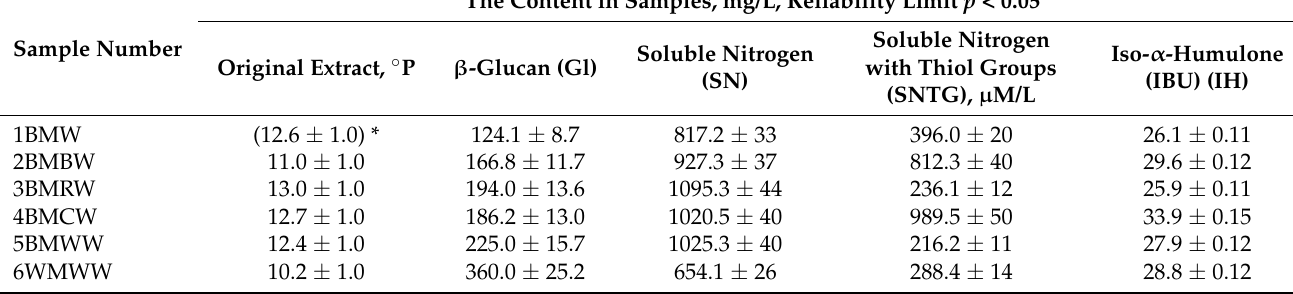
Table 4. The characteristics of wort samples.